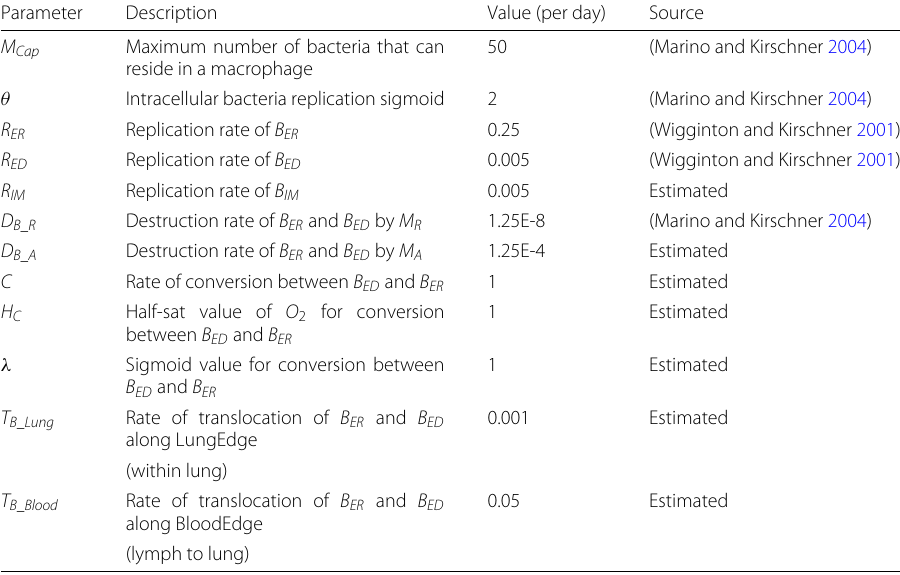
due to the limitations on the number of immune cells that can encounter the bacteria during the early stages on infection. An adaptive immune response begins to quell the infection, but in doing so it results in transfer of the bacteria to other areas of the lung. An oscillating process of bacterial growth occurs, with bacteria numbers increasing and decreasing over time, but never reaching the levels of the initial growth explosion. This can be seen as a latent form of TB: the bacteria levels are contained but not eradicated. As all patches contain the same values for their attributes, the bacteria levels at each patch Table 3 Bacterial event parameters used for experiments, unless specified in the text Parameter Description Value (per day) Source 50 (Marino and Kirschner 2004) (Marino and Kirschner 2004) (Wigginton and Kirschner